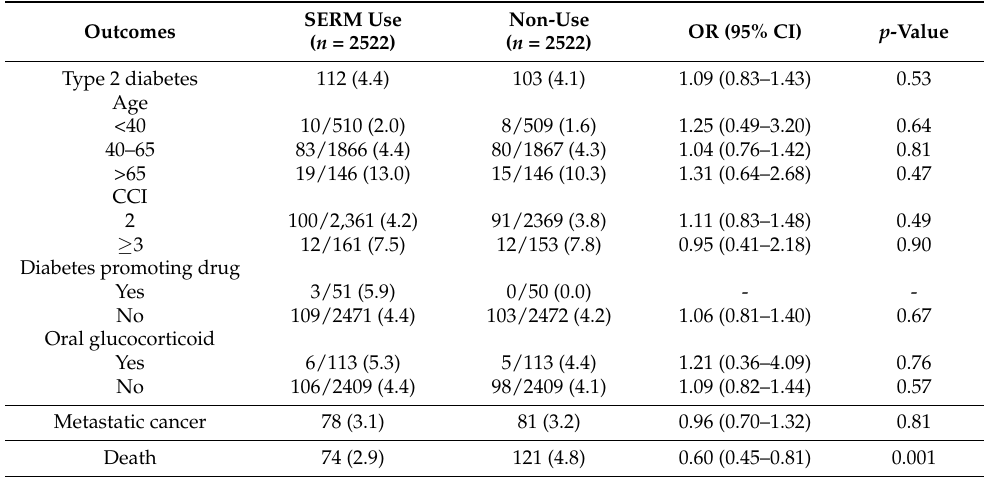
Table 2. PS-matched analysis of clinical outcomes for SERM use versus non-use ( n = 5044).